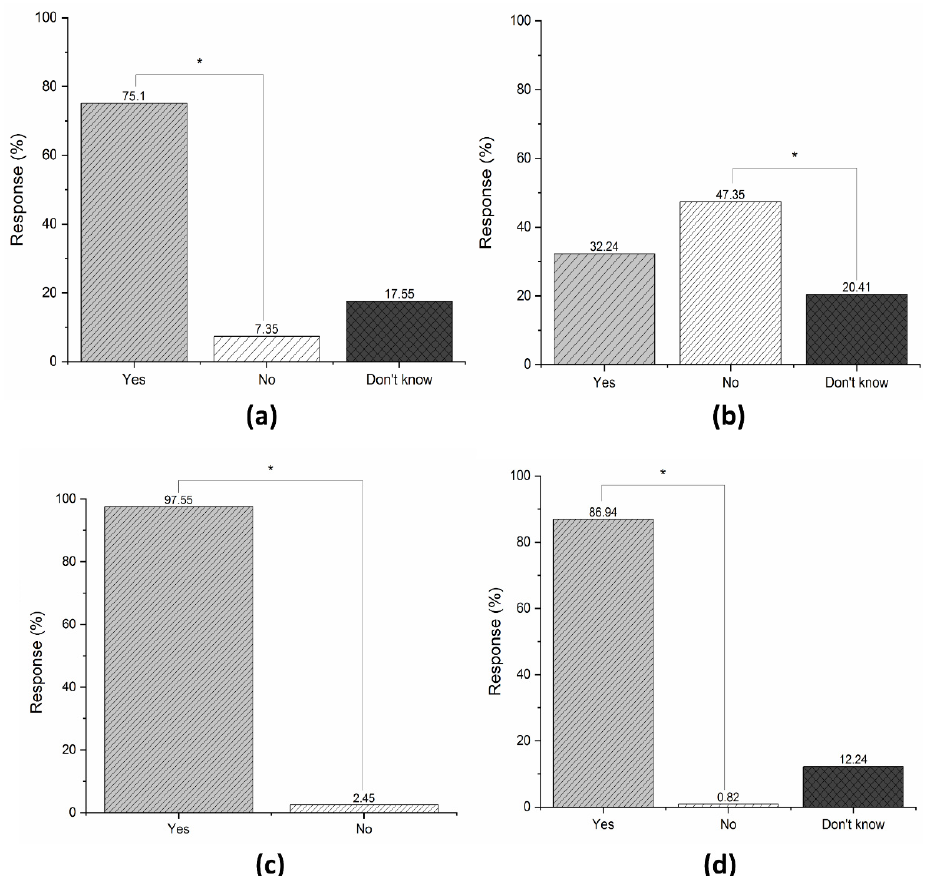
Figure 8. Perception of professionals as evaluated using the following survey questions: ( a ) Do you